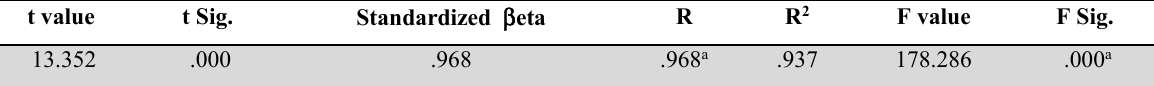
Results of simple linear regression to test the impact of board of directors’ size effect on return on assets (ROA) indicator value t Sig. t